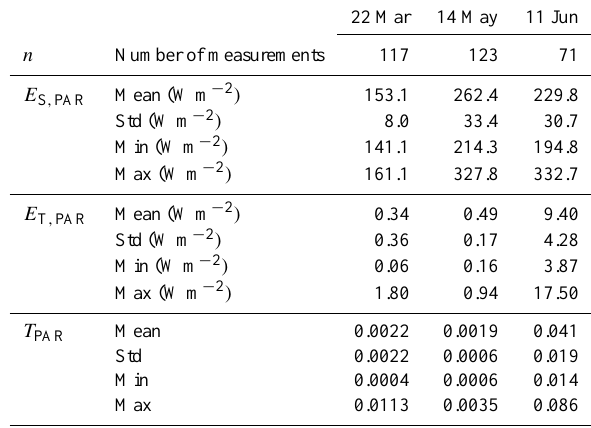
Table 2. Incident solar radiation fluxes above ( E S , PAR ) and under ( E T , PAR ) sea ice, as well as transmittance ( T PAR ) of photosynthetic active radiation